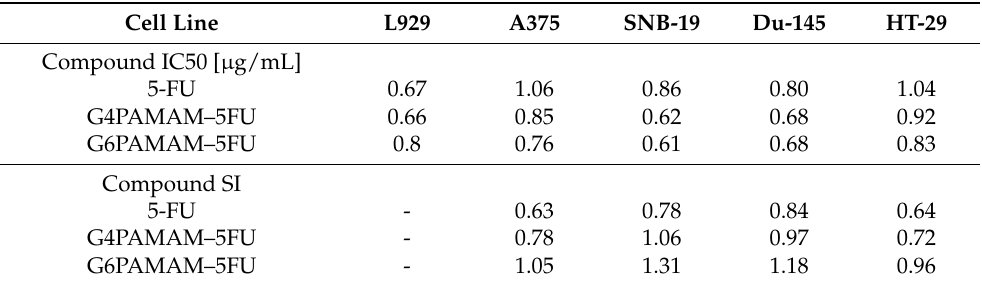
Figure 8. The cytotoxicity of G4PAMAM and G6PAMAM dendrimers and their complexes with 5FU towards cell lines of: ( a ) melanoma (A375); ( b ) glioblastoma (SNB-19); ( c ) prostate cancer (Du-145); ( d ) colon adenocarcinoma (HT-29), measured with MTS assay following a 7 day incubation with the compounds. Table 5. The half maximal inhibitory concentration (IC50) values and the selectivity index (SI) values of 5-fluorouracil alone (5-FU) or conjugated with G4PAMAM or G6PAMAM dendrimers (G4PAMAM– 5FU and G6PAMAM–5FU, respectively) in 5 cell lines: mouse fibroblasts (L929) malignant melanoma (A375), glioblastoma (SNB-19), prostate cancer (Du-145) and colon adenocarcinoma (HT-29) following a 7 day incubation with the